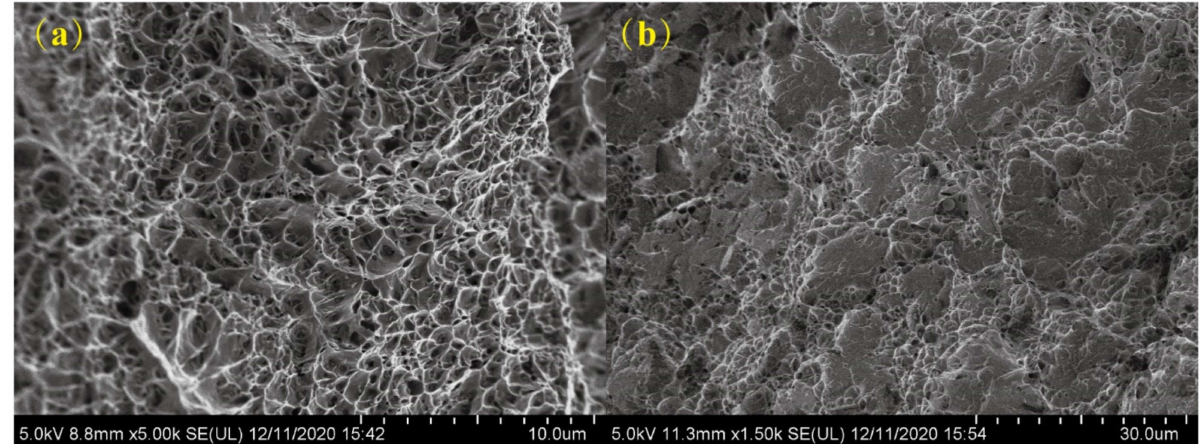
Figure 6. Tensile fracture morphology of samples No. 4 # : ( a ) base materials (BM); ( b )